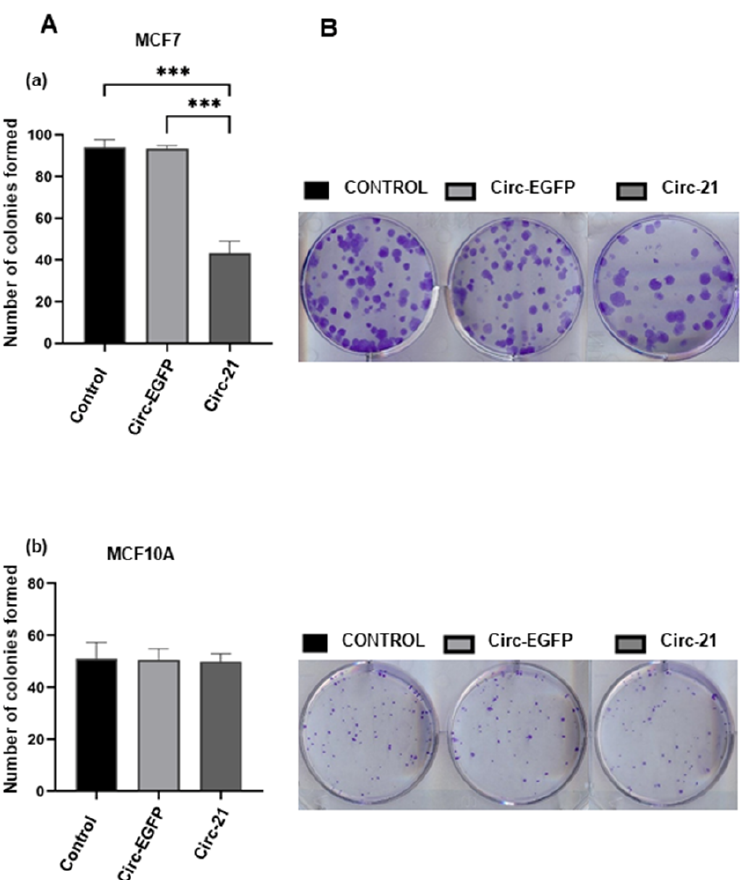
Figure 5. Effects of the Circ-21 on colony formation. ( A ) Circ-21, Circ-EGFP and control group of the MCF7 ( a ) and the MCF10A ( b ) cell lines were analyzed for 10 days by colony formation assay. The Circ-21 led to a decrease colony numbers in the MCF7 cells, but not in the MCF10A cells. Values represent means ± SD ( n = 3). *** p < 0.001. ( B ) Representative image of colony formation.